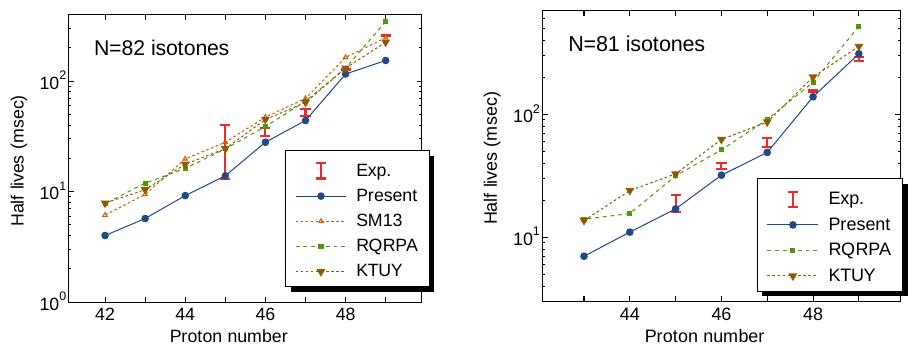
Figure 3. β -decay half-lives of N = 82 (left panel) and N = 81 (right panel) isotones. The red symbols with error bars denote the experimental values [14]. The blue circles, orange triangles, green squares, and brown inverted triangles denote those of the present shell-model study, the previous shell-model study [9], the relativistic QRPA [11], and the gross theory [13] with the KTUY mass formula [12],